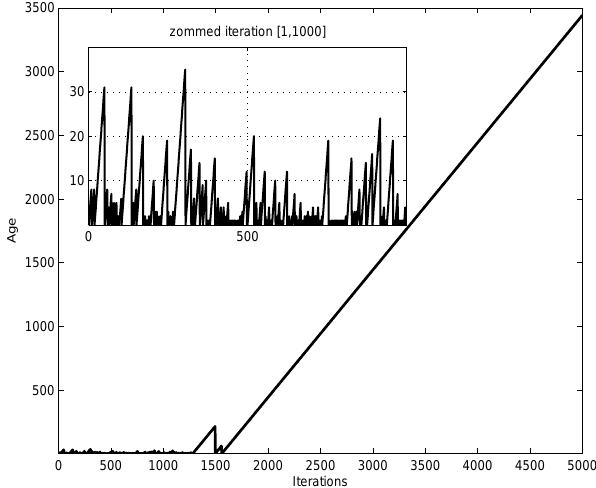
Fig. 1. Example of the change in age of a particle when using basic PSO to optimize 30-D Rastrigin